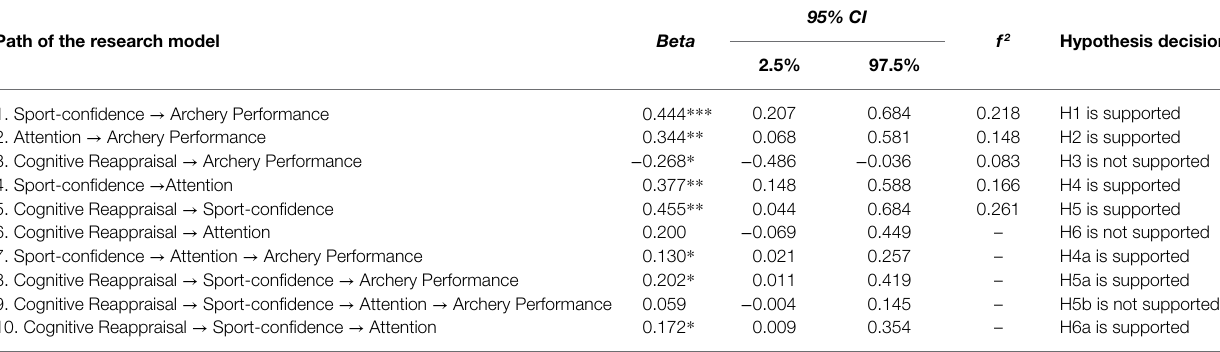
TABLE 5 | Path coefficients of the structural model and significance testing results.